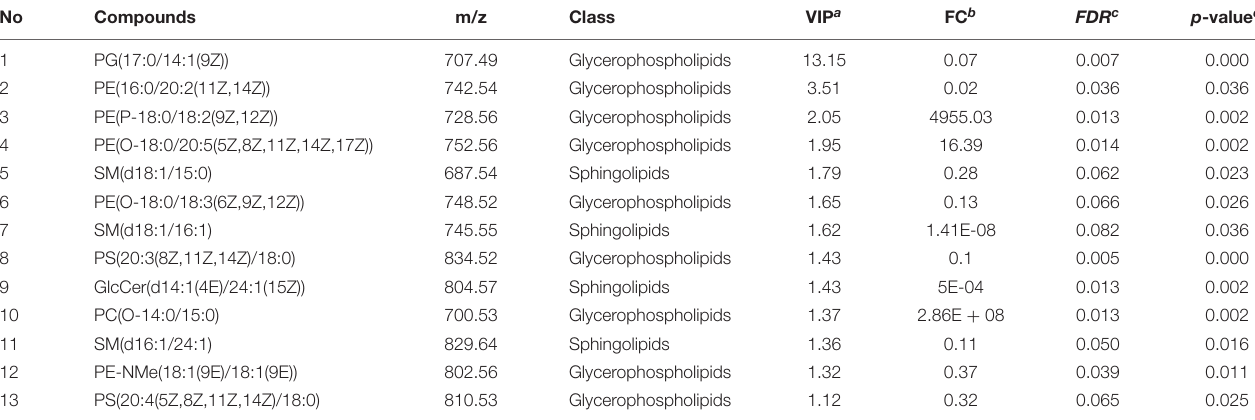
TABLE 2 | Identified differentiating lipids between thyroid papillary cancer patients and healthy controls.